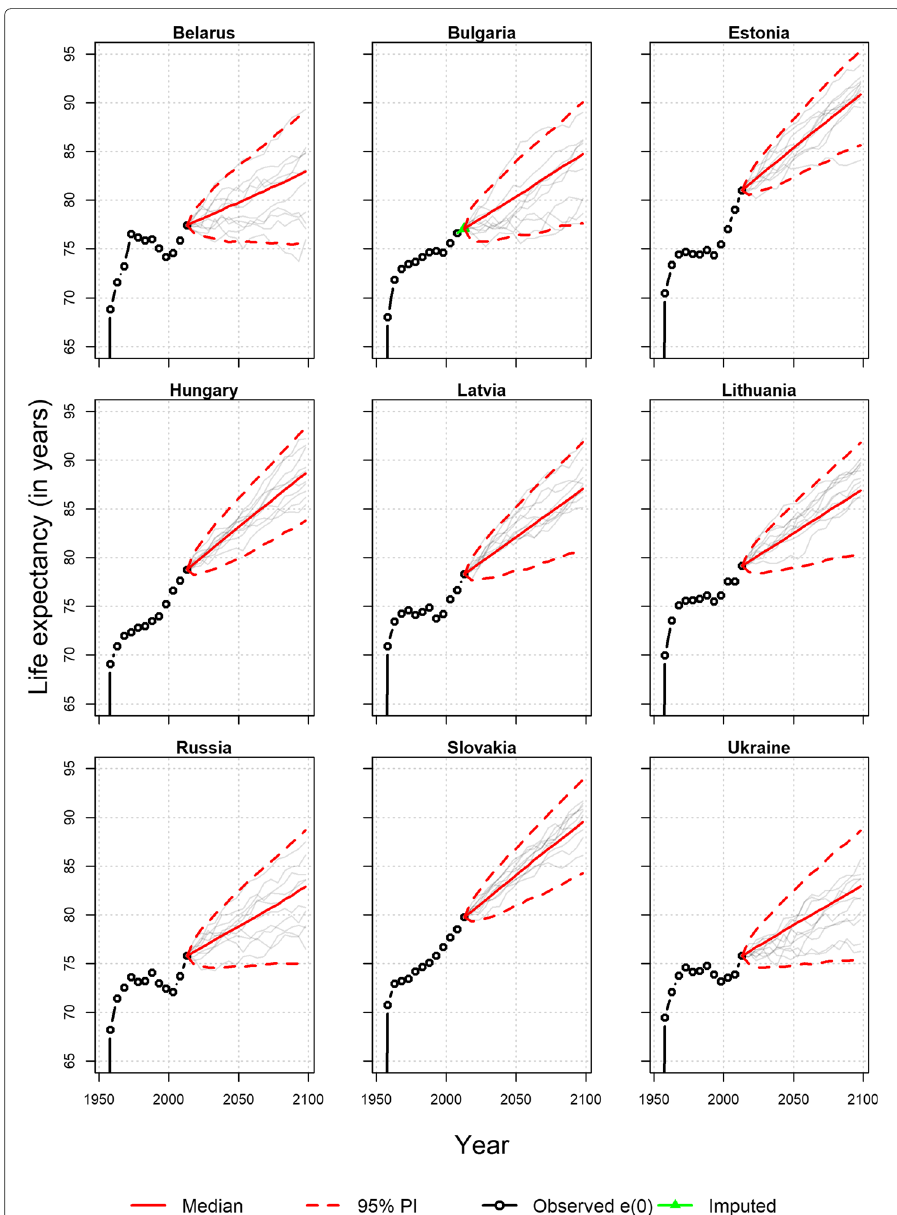
Fig. 11 Forecast of life expectancy at birth for (comparatively) high mortality countries by UN forecast with 95% prediction interval. Results are showed for females